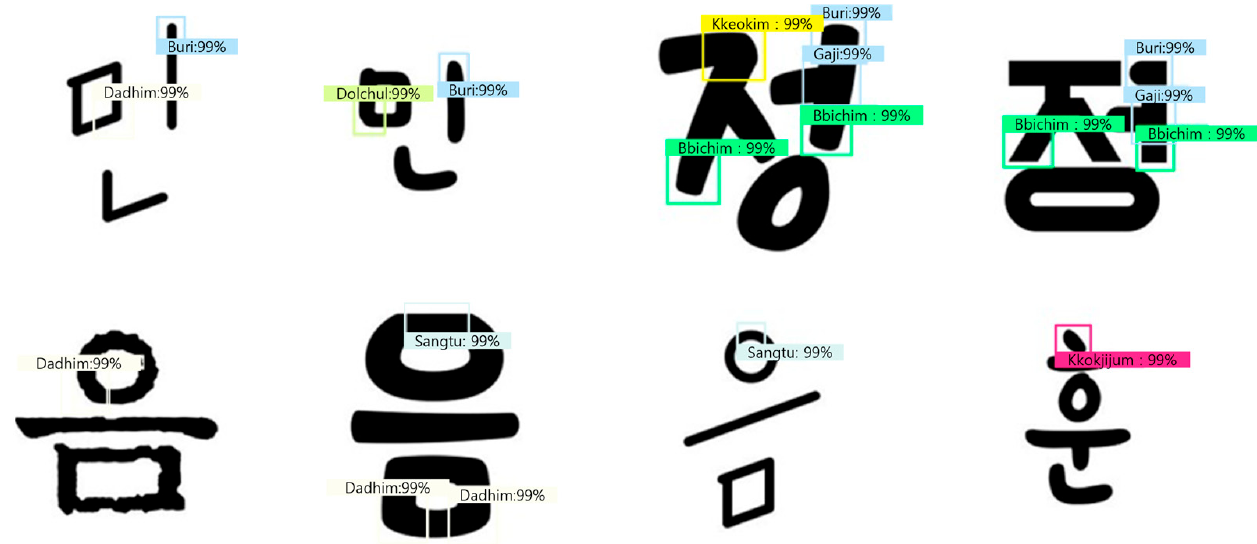
Figure 9. An example image of the detection result of Group B .